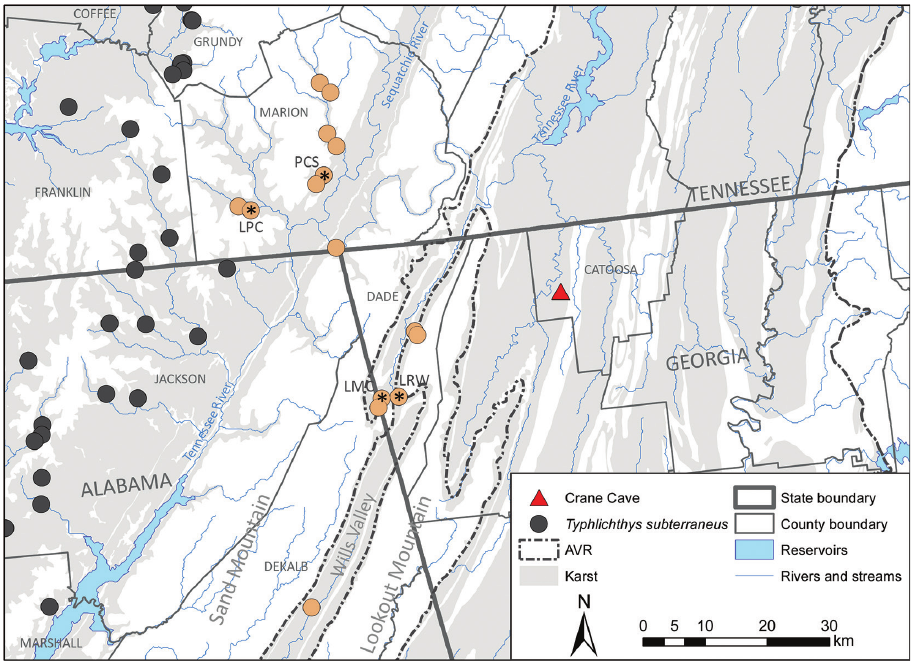
Figure 3. Distribution of Typhlichthys subterraneus (solid circles) in southeastern Tennessee, northeastern Alabama, and northwestern Georgia. The new record at Crane Cave is denoted with a red triangle and lin- eage A localities are highlighted in peach. Lineage A populations that have been genetically examined are marked with an asterisk and labeled as follows: LMC – Limestone Caverns, LPC – Lost Pig Cave, LRW – Long’s Rock Wall, and PCS – Pryor Cave Spring. Counties with Typhlichthys records are labeled. Karst and cave-bearing strata are shaded gray based on the U.S. karst map (Weary and Doctor 2014). The border of the Appalachian Valley and Ridge (AVR) physiographic province is denoted by the dot and dashed